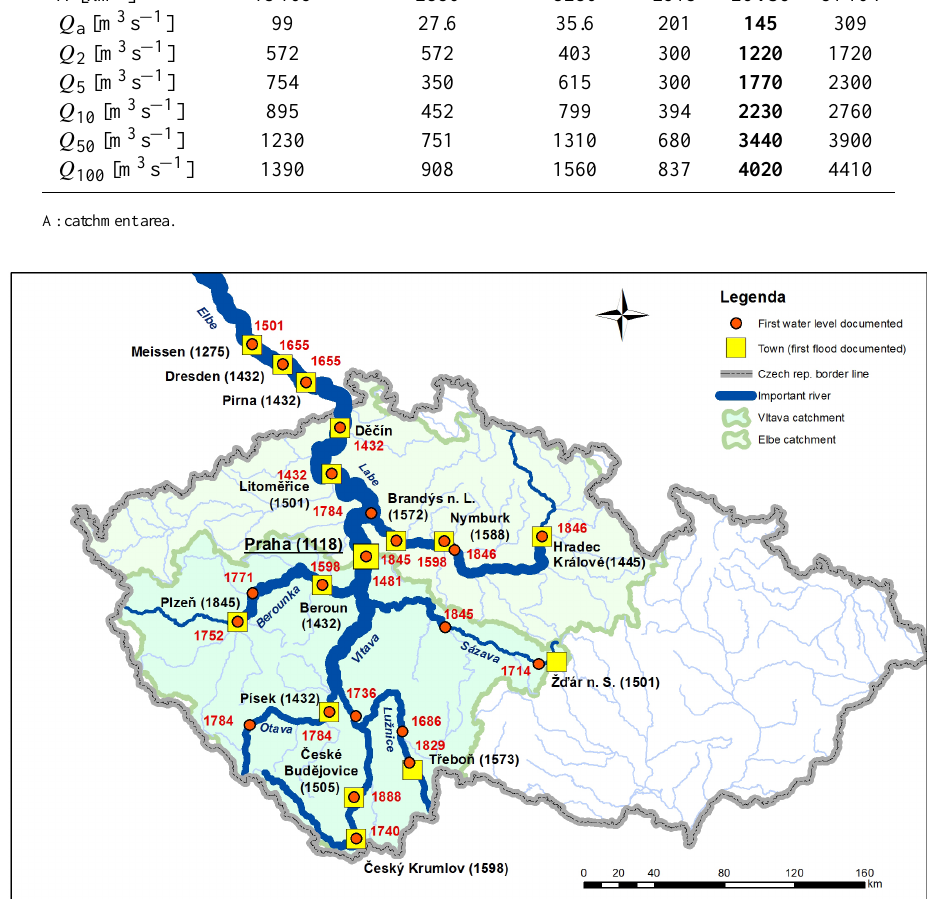
Figure 1. The Vltava River catchment. The major tributaries and sites with records of historic floods and flood marks are highlighted.